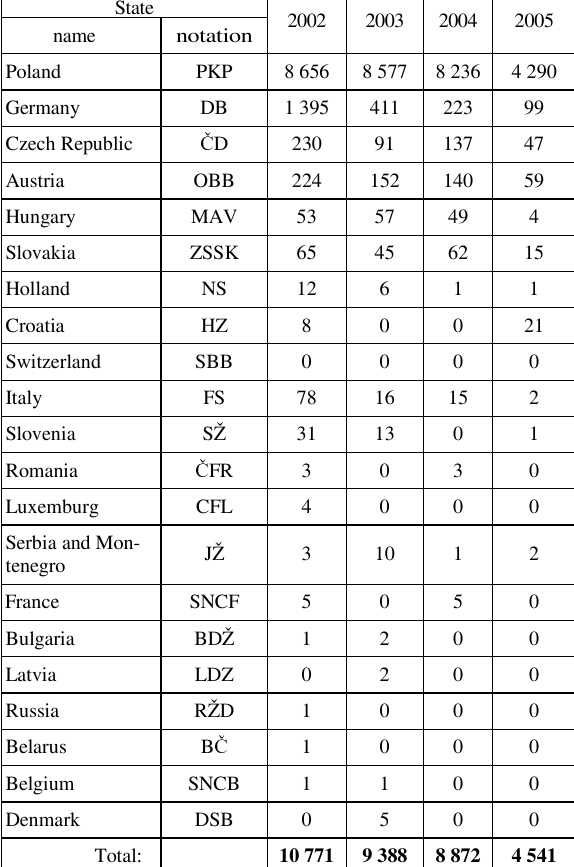
Fig 1. Dynamics of the number of passengers, transported by